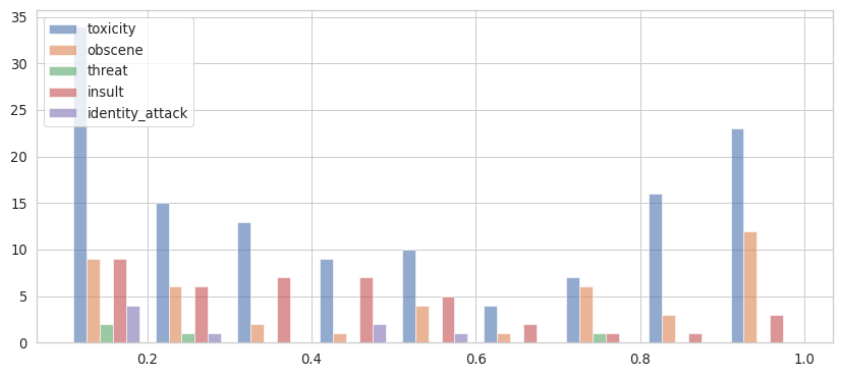
Figure 14. Histogram of Odysee comments’ toxicity detection.